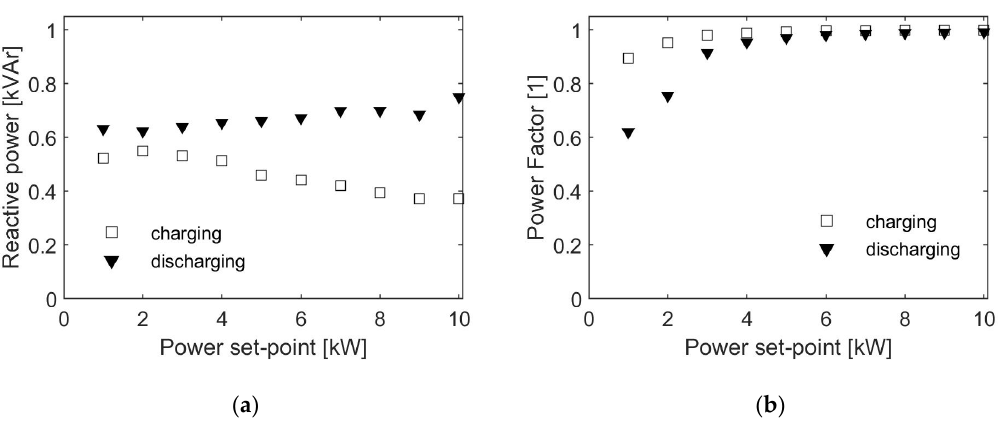
Figure 10. ( a ) Reactive power; ( b ) and power factor for the requested power set points, both in charge (squares) and discharge (filled triangles) modes. In both modes, the EVSE injects reactive power into the grid and the power factor degrades for requested power values that fall below 4 kW (40% of the EVSE nominal power). Each value represents the average of four identical tests, with a standard deviation ranging ±0.3 and ±0.7 kVAr and ±0.01 and ±0.03 for reactive power and power factor, respectively.